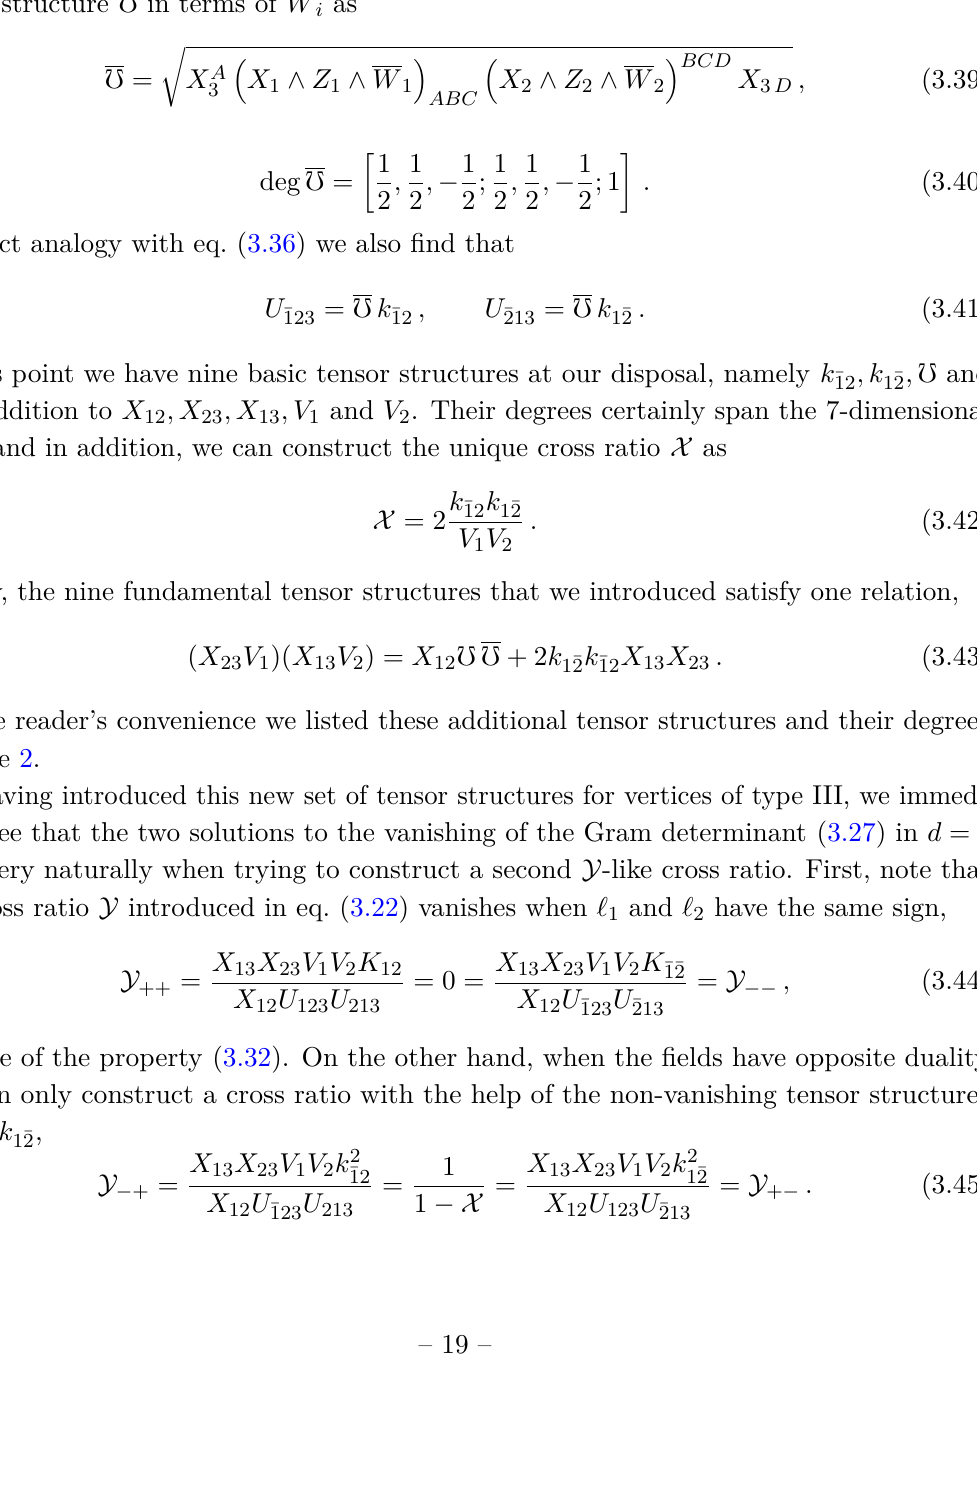
The tensor structure f uses only W tensor structure f in terms of W